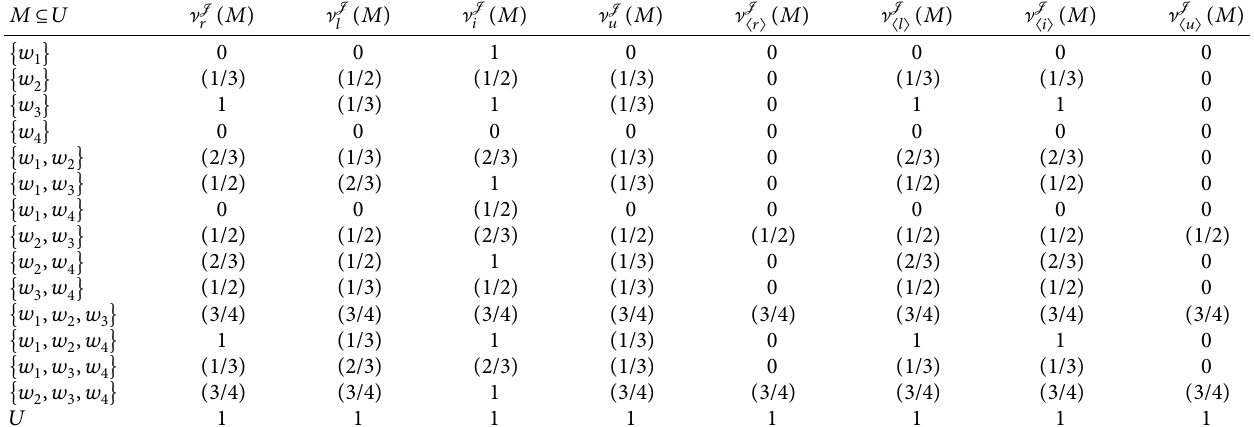
j ∈ r, l,i,u, 〈 r 〉 , 〈 l 〉 , 〈 i 〉 , 〈 u 〉{ } j -accuracy measures for